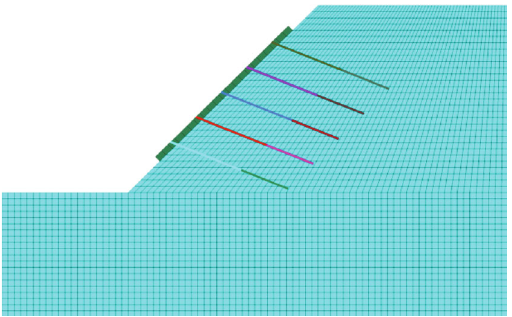
Figure 13: Slope model with